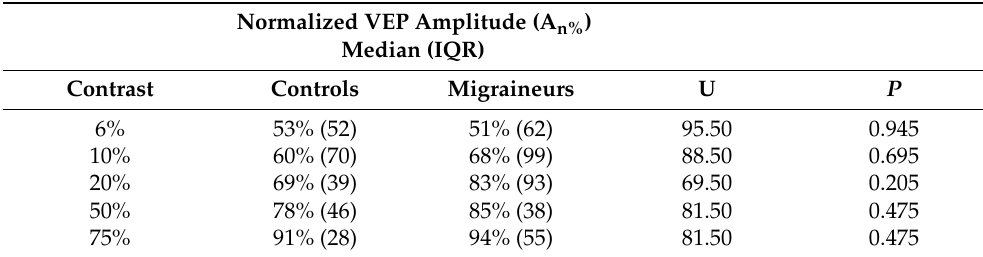
Table 2. The normalized amplitude at single contrast confronting migraineurs and controls.